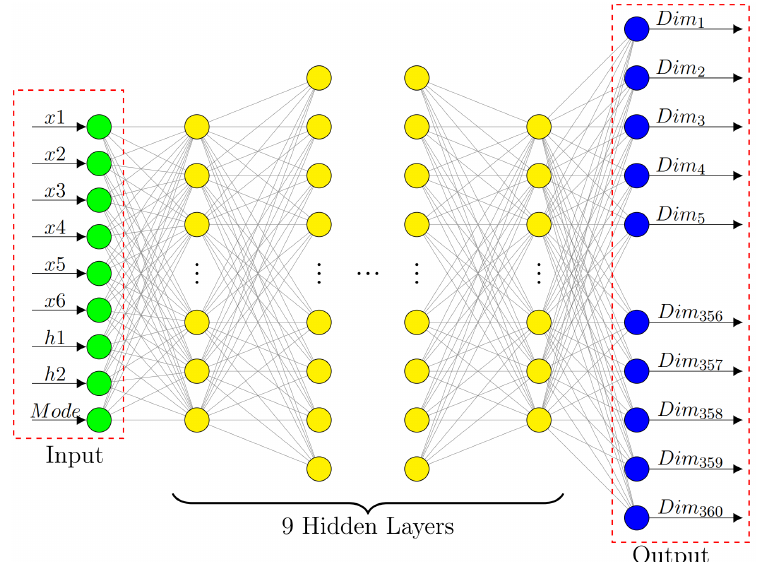
Figure 2. DNN network structure and input/output parameters. Table 1. DNN network model